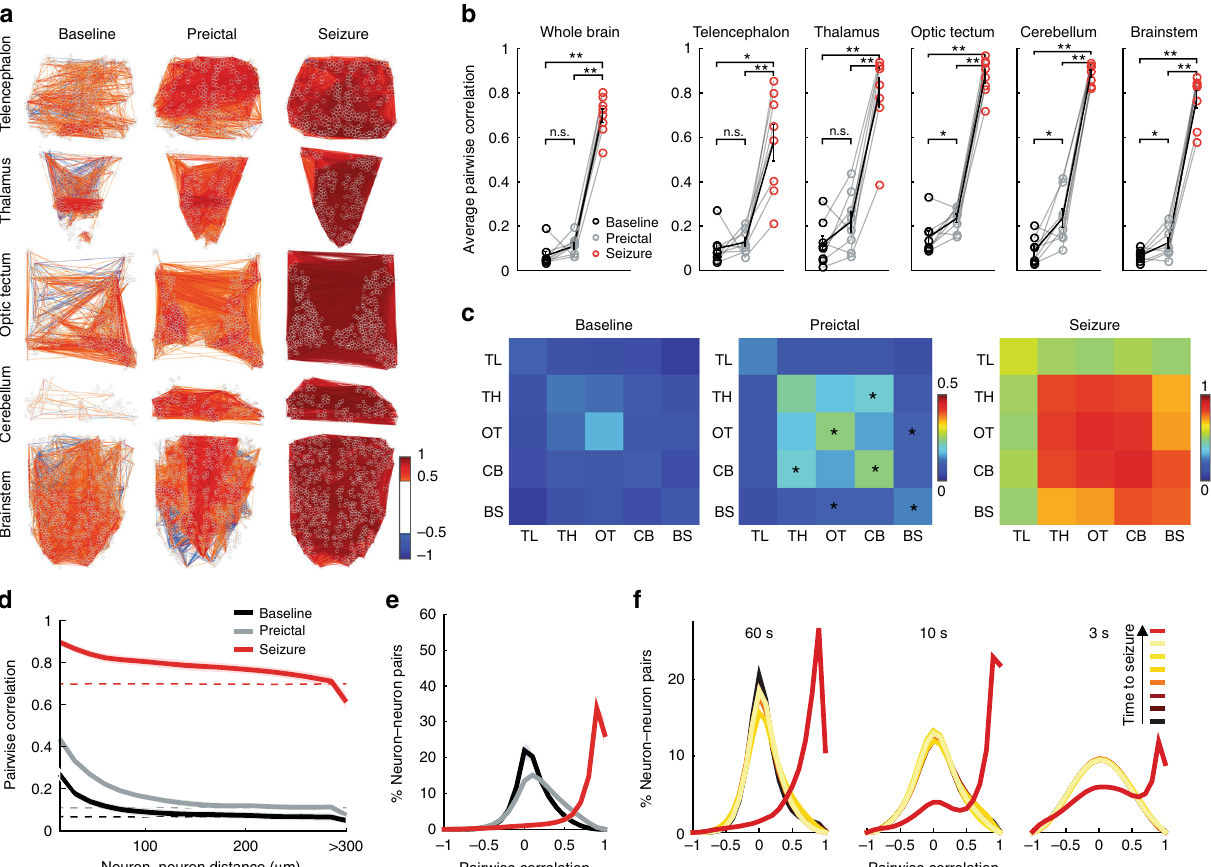
Fig. 3 Functional connectivity between neurons changes abruptly from the preictal period to the generalized seizure. a A map depicting pairwise Pearson ’ s correlation coef fi cients of neural activity within brain regions during baseline, preictal and seizure periods. Each colored line indicates a strong positively (>0.5 in red) or negatively (< − 0.5 in blue) correlated activity between pairs of neurons located at the end of the lines. b Average pairwise Pearson ’ s correlation during baseline (black), preictal (gray), and seizure (red) periods across the whole brain, and within individual brain regions. c Correlation matrices indicating average pairwise Pearson ’ s correlations of neural activity during baseline, preictal and seizure, across brain regions (telencephalon, TL; thalamus, TH; optic tectum, OT; cerebellum, CB; and brainstem, BS). Warmer colors indicate stronger positive correlations. d Relation between pairwise correlation of neural activity and distance between each neuron pair. Dotted lines represent the results when neural locations are shuf fl ed. e Histogram representing the distribution of all correlation coef fi cients between neurons from all animals during baseline (black), preictal (gray), and seizure periods (red). f Correlation coef fi cients during seven time periods immediately preceding a generalized seizure. The time periods are of 60, 10, and 3 s length, respectively. Lighter colors indicate temporal proximity to the seizure. ** p = < 0.01, * p = < 0.05, ns = not signi fi cant, Wilcoxon signed-rank test. Error bars ( b ) and shaded regions ( d – f ) represent the s.e.m. of n = 8 fi